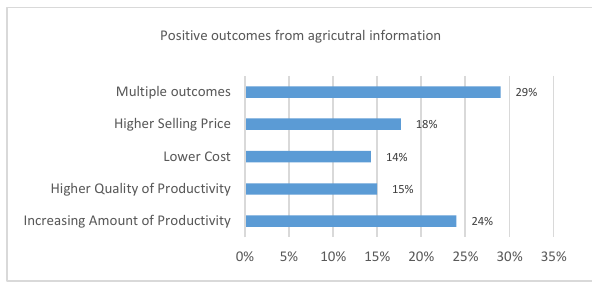
Figure 6: Positive outcomes from agricultural